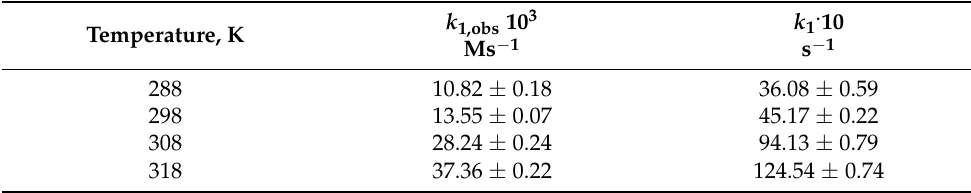
Table 2. Values of the pseudo zero-order and zero-order rate constants for redox reaction of